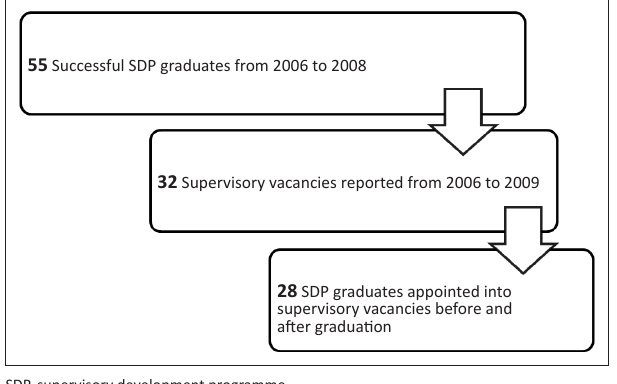
FIGURE 4: Supervisory development programme graduate appointments into vacant junior management and supervisory positions from 2006 to